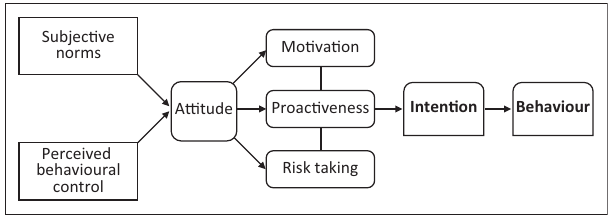
FIGURE 1: Structural diagram of the relationship between entrepreneurial intention and entrepreneurial